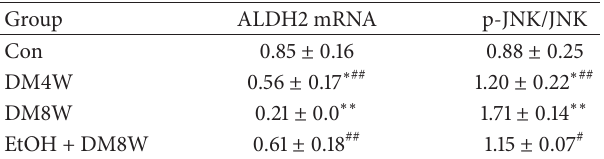
Table 3: The result of ALDH2 mRNA and p-JNK/JNK protein expression. Group ALDH2 mRNA p-JNK/JNK Con 0.85 ± 0.16